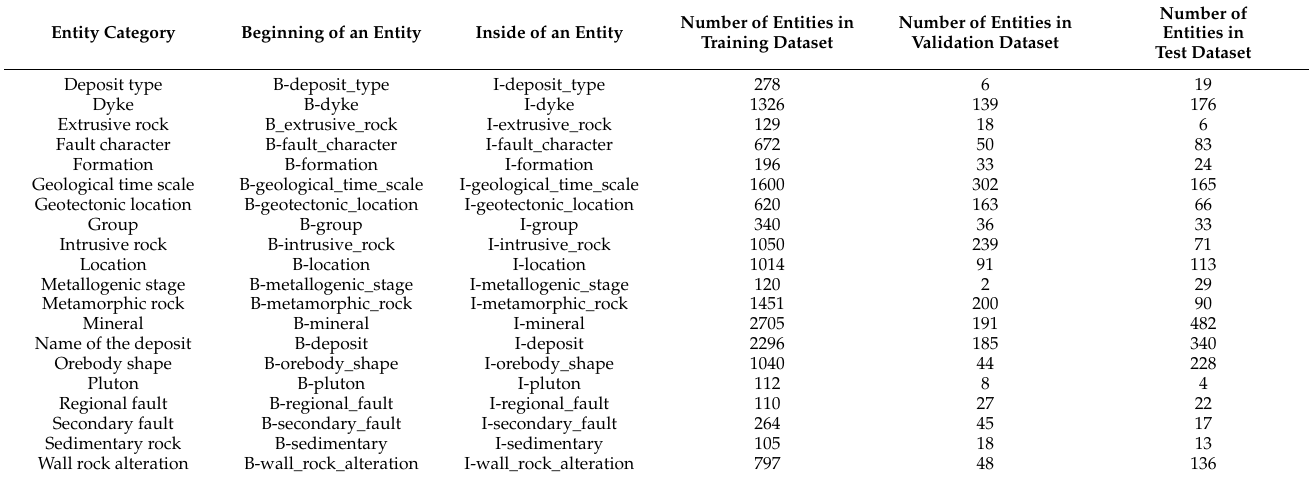
Table 1. Labeling with the domain dictionary with the resolution rules applied.